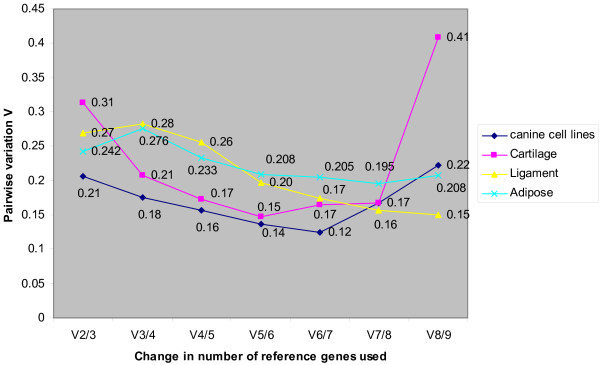
Pairwise variation analysis for determining optimal number of reference genes in various canine tissues (healthy and diseased).